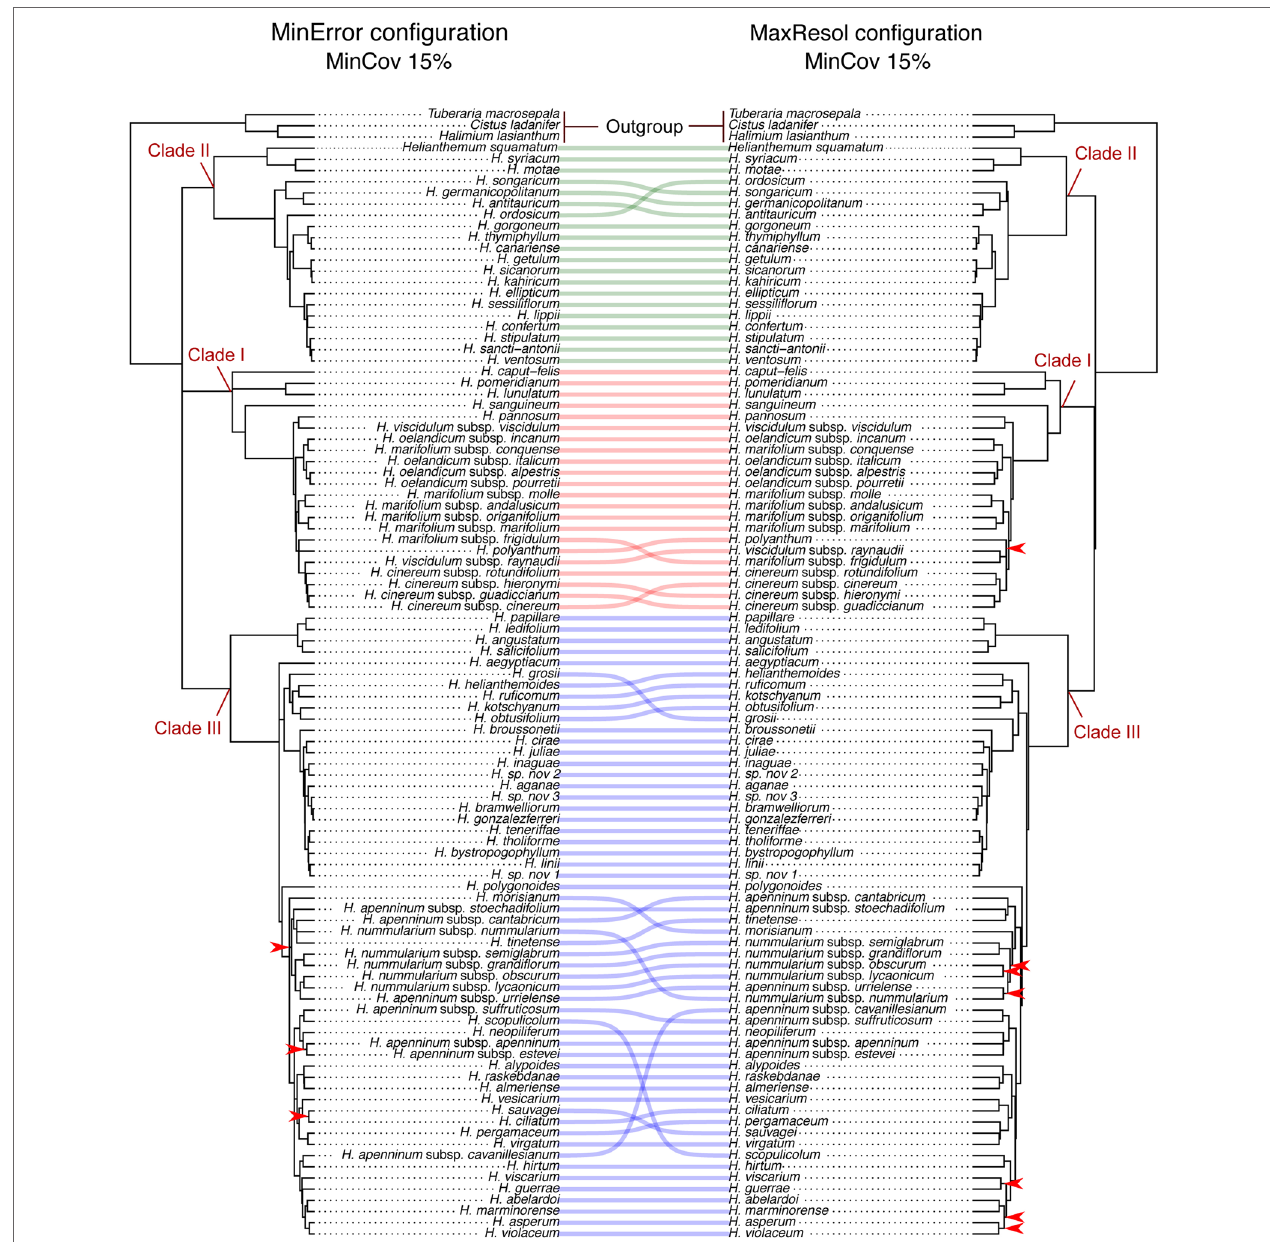
FIGURE 2 | Comparison of 50% majority-rule consensus trees resulting from Bayesian analyses of Helianthemum GBS data in ExaBayes using the two extreme parameter configurations (MaxResol, maximizing phylogenetic resolution; and MinError, minimizing allele and SNP error rates) under 15% minimum taxon coverage. Red arrows indicate unsupported clades (PP < 0.95). Supported incongruences between analyses are highlighted with defined coloured lines, green in Clade II, red in Clade I, and blue in Clade III. Clades I, II and III are coincident with those in Aparicio et al., 2017.